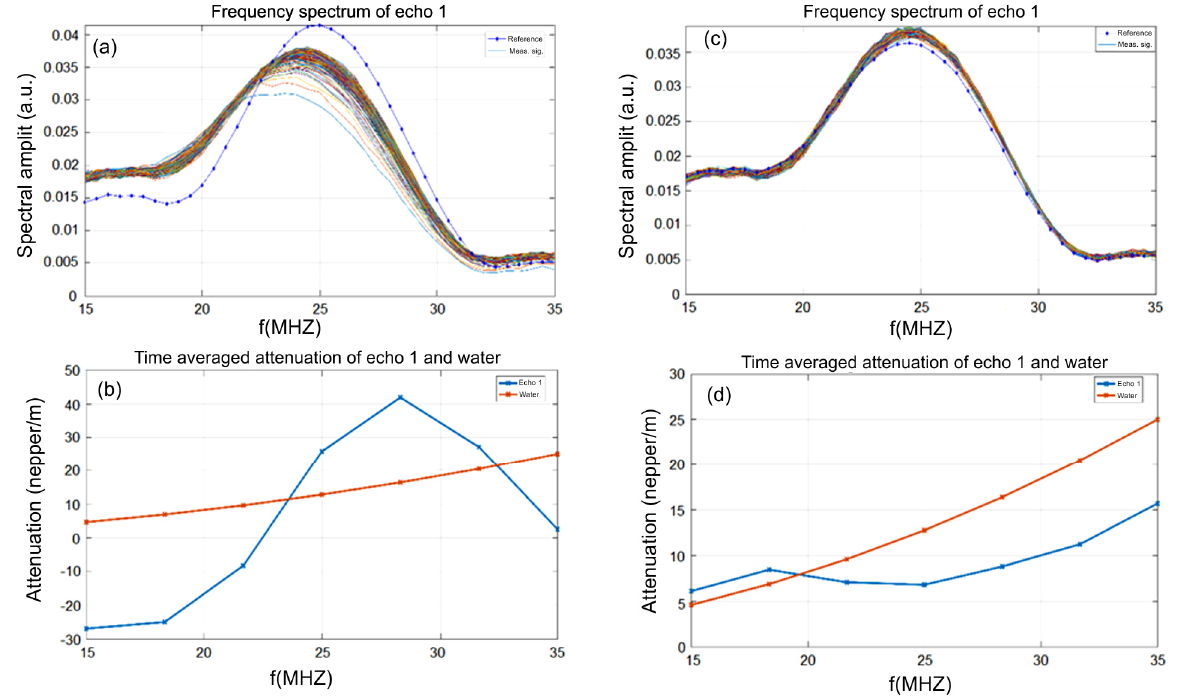
Figure 9. Frequency spectrum of echo 1 before ( a ) and after strontium removal ( c ). Time-averaged attenuation of echo 1 and water before ( b ) and after strontium removal ( d ).